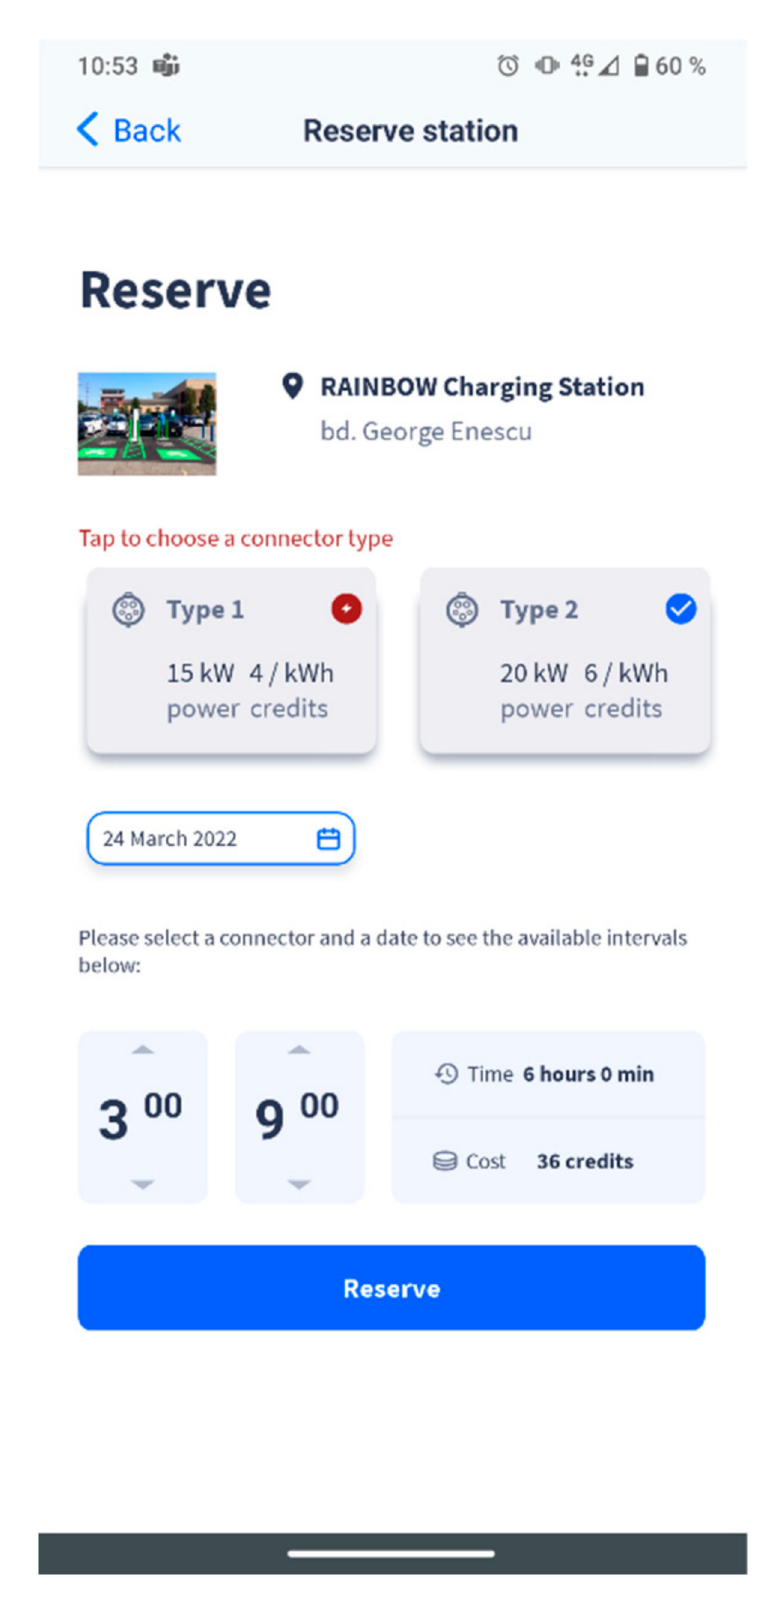
Figure 8. Smart EVC